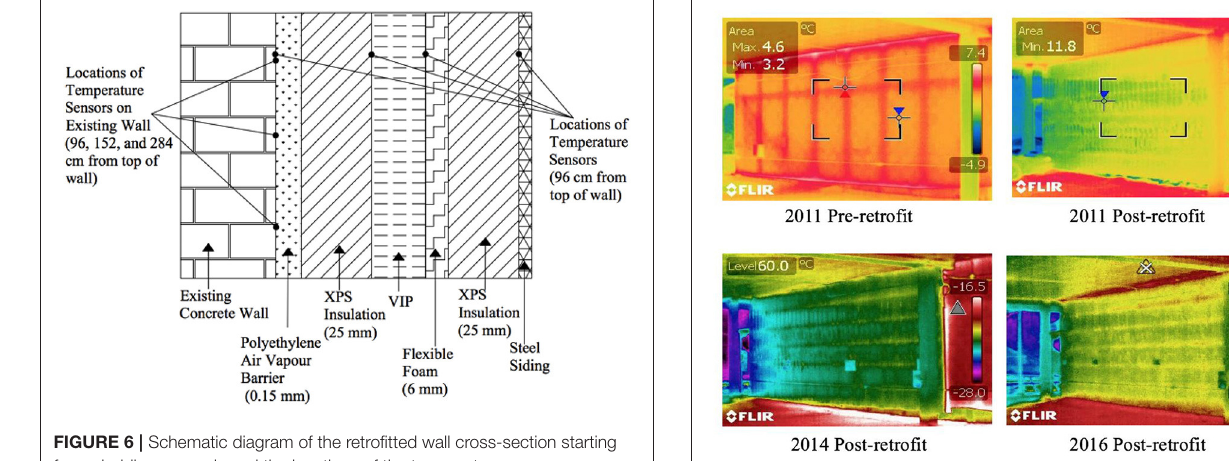
(interior) and second (exterior) layers of XPS are 14.48